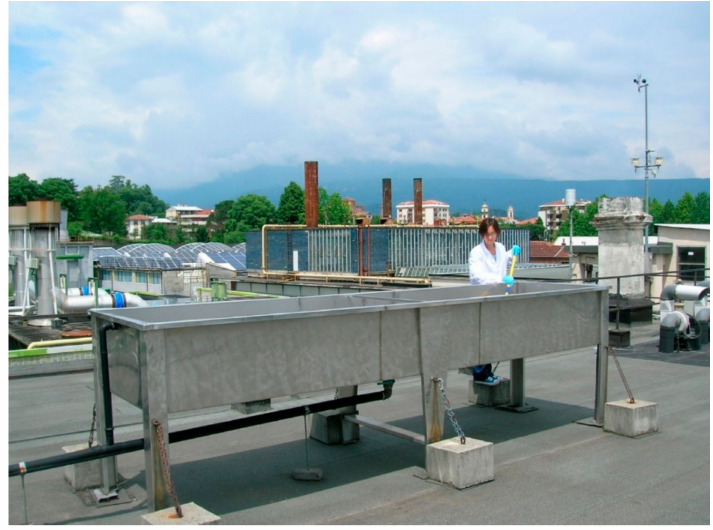
Figure 2. The stainless steel tank placed on the roof of the building for the collection of the wet and dry deposition samples. Every month, at the end of the sampling period, the deposition is collected and dried. The residue is then weighed, placed in a small jar and measured by means of an hyperpure gamma-X (n-type) germanium detector (40% relative efficiency), able to detect the low energy 46.5 keV gamma emission of 210 Pb (see Figure 3).